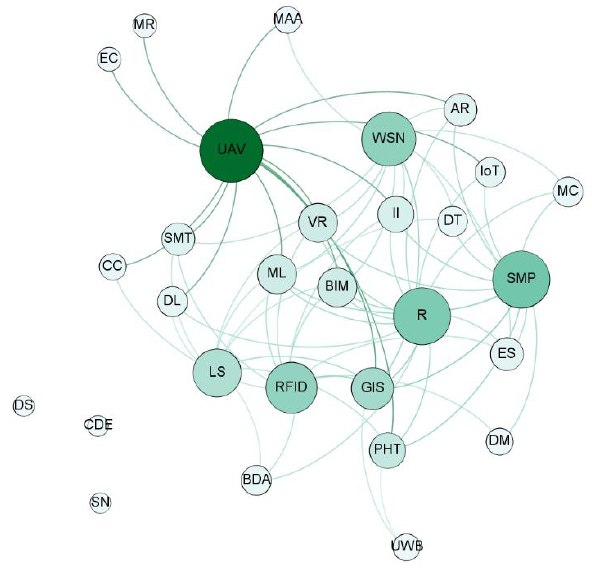
Figure 8. Interconnection network analysis—betweenness.